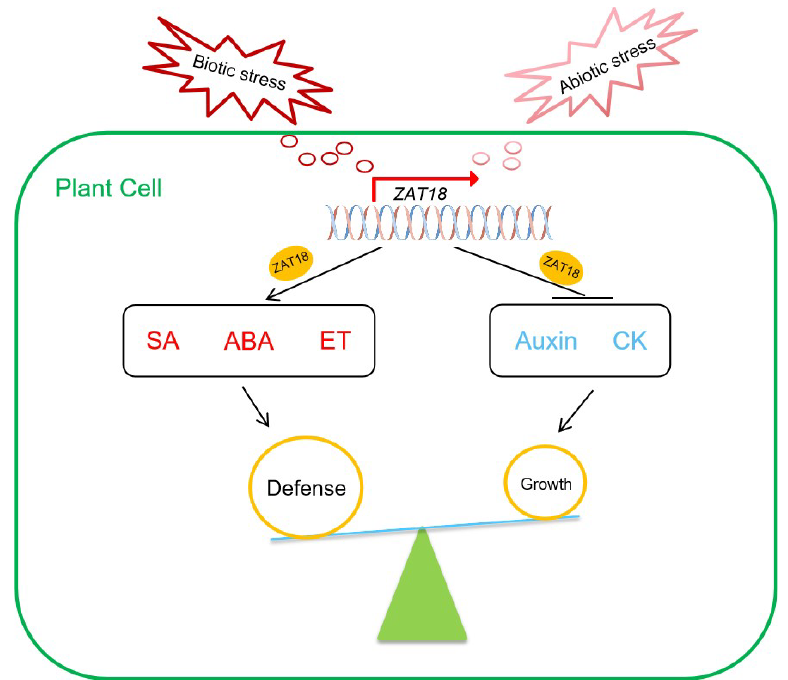
Figure 8. The working model of ZAT18. Under stress conditions, the expression of ZAT18 is induced. As a transcription factor, ZAT18 induces plant defense by upregulating the SA, ET and ABA pathways. Meanwhile, the auxin and CK pathways are repressed by ZAT18 to inhibit plant growth.